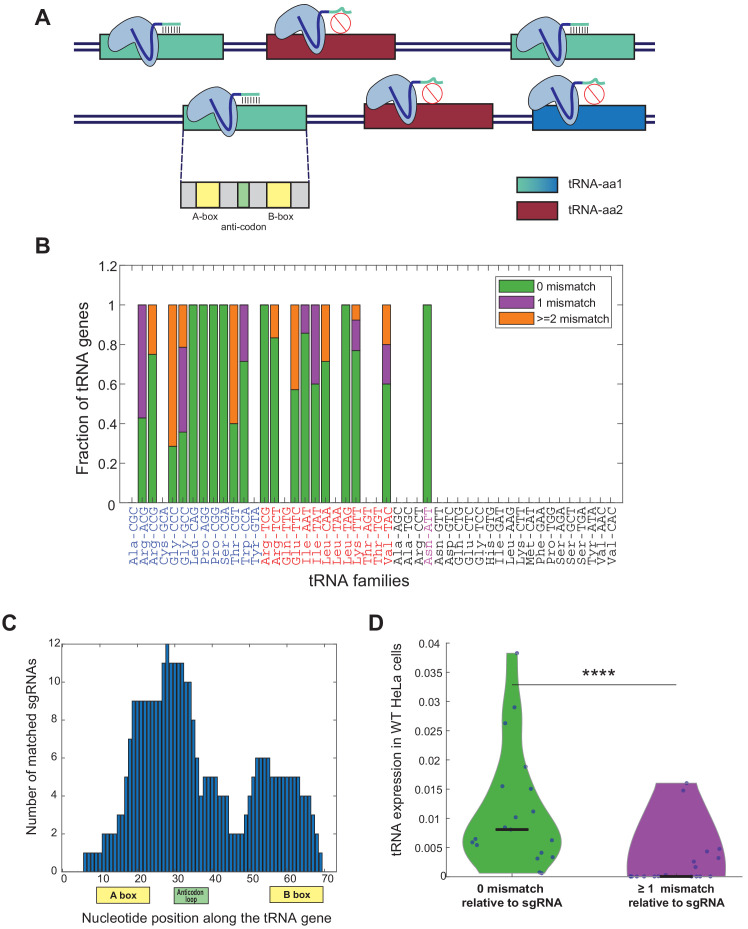
sgRNA library design for genomic editing of human tRNA genes.(A) A schema illustrating the sgRNA design for tRNA targeting. The hypothetical tRNA-aa1 family (blue tRNA genes) is targeted by the light-blue sgRNA. Three out of the four tRNA genes (light blue tRNA genes) are fully match to the sgRNA sequence, while the fourth gene has sequence dissimilarities (dark blue tRNA gene), thus predicted not to be targeted by the sgRNA. The hypothetical tRNA-aa2 family (bordeaux tRNA genes) is not predicted to be targeted by the light-blue sgRNA, due to lack of complementarity between the sequences. In addition, the sgRNAs are designed to target functional sequence regions along the tRNA gene to maximize the manipulation effect on the targeted tRNA. (B) A bar plot representing the sequence similarity of the tRNA genes to the corresponding sgRNAs. Each bar denotes a tRNA family in the human genome, overall, 19 out of the 46 tRNA families and one (AsnATT) out of two pseudo tRNA families were targeted. The y-axis denotes the fraction of CRISPR-targeted tRNA genes for each tRNA family (considering only tRNA genes with tRNA score >50, except of the pseudogene AsnATT tRNA family which consists of two genes with tRNA score <50 (colored in pink) [Lowe and Chan, 2016]). The colors in the bars describe the variety of sequence similarity of the tRNA family to the sgRNA sequence (full match in green, one mismatch in purple and two or more mismatches in orange). The tRNA identity is colored according to the differentiation (blue)/proliferation (red)/others (black) classification. (C) A histogram of the location of the sgRNA sequences along the tRNA genes. The x-axis depicts the nucleotide position along the tRNA, with the A box, B box, and the anticodon loop marked. The y-axis depicts the number of sgRNAs that are complementary to each nucleotide. (D) A violin plot describing the distribution of expression levels, in WT HeLa cells, of perfectly matched and non-perfectly matched tRNA genes to their corresponding sgRNAs. The expression of each tRNA family in HeLa cells was calculated by the sum expression of the tRNA genes, averaged over two biological repeats. The distributions are significantly different, -Wilcoxon rank-sum test, p<10−4.
Figure 1—source data 1.sgRNA sequences.